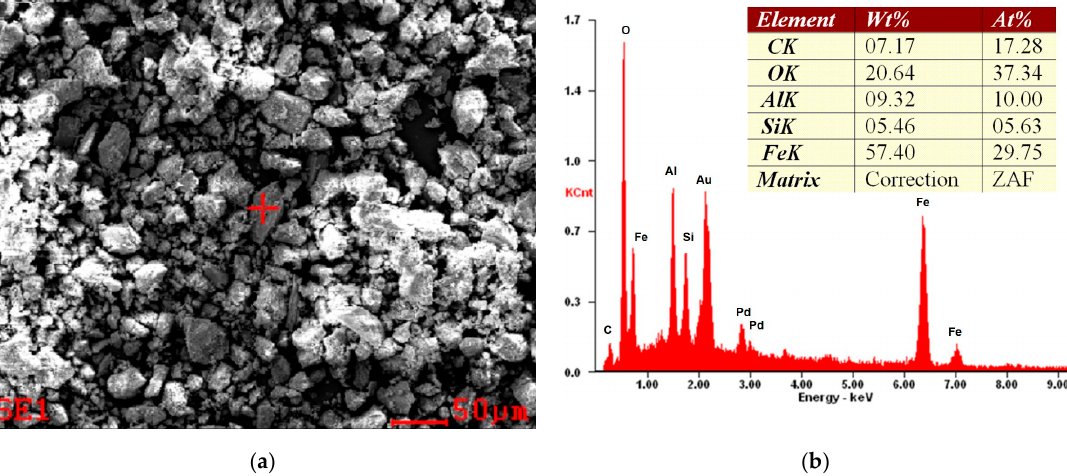
Figure 5. Example of SEM micrograph ( a ) and EDS spectra ( b ) of the halloysite sample from the Dunino deposit. The sample was sputtered by the Au/Pd target. EDS results indicate impurity, probably in the form of the iron compound.